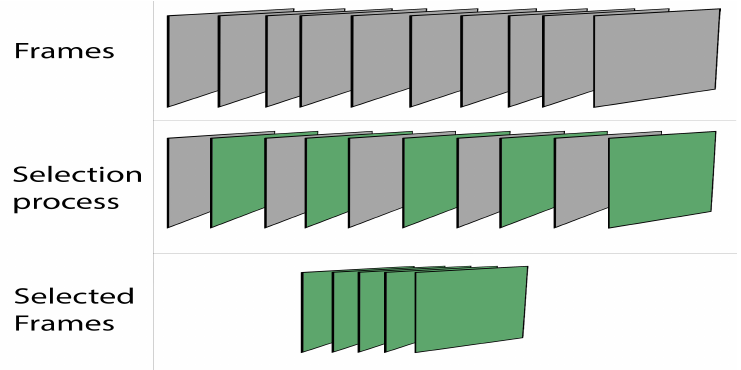
Figure 3. Selection